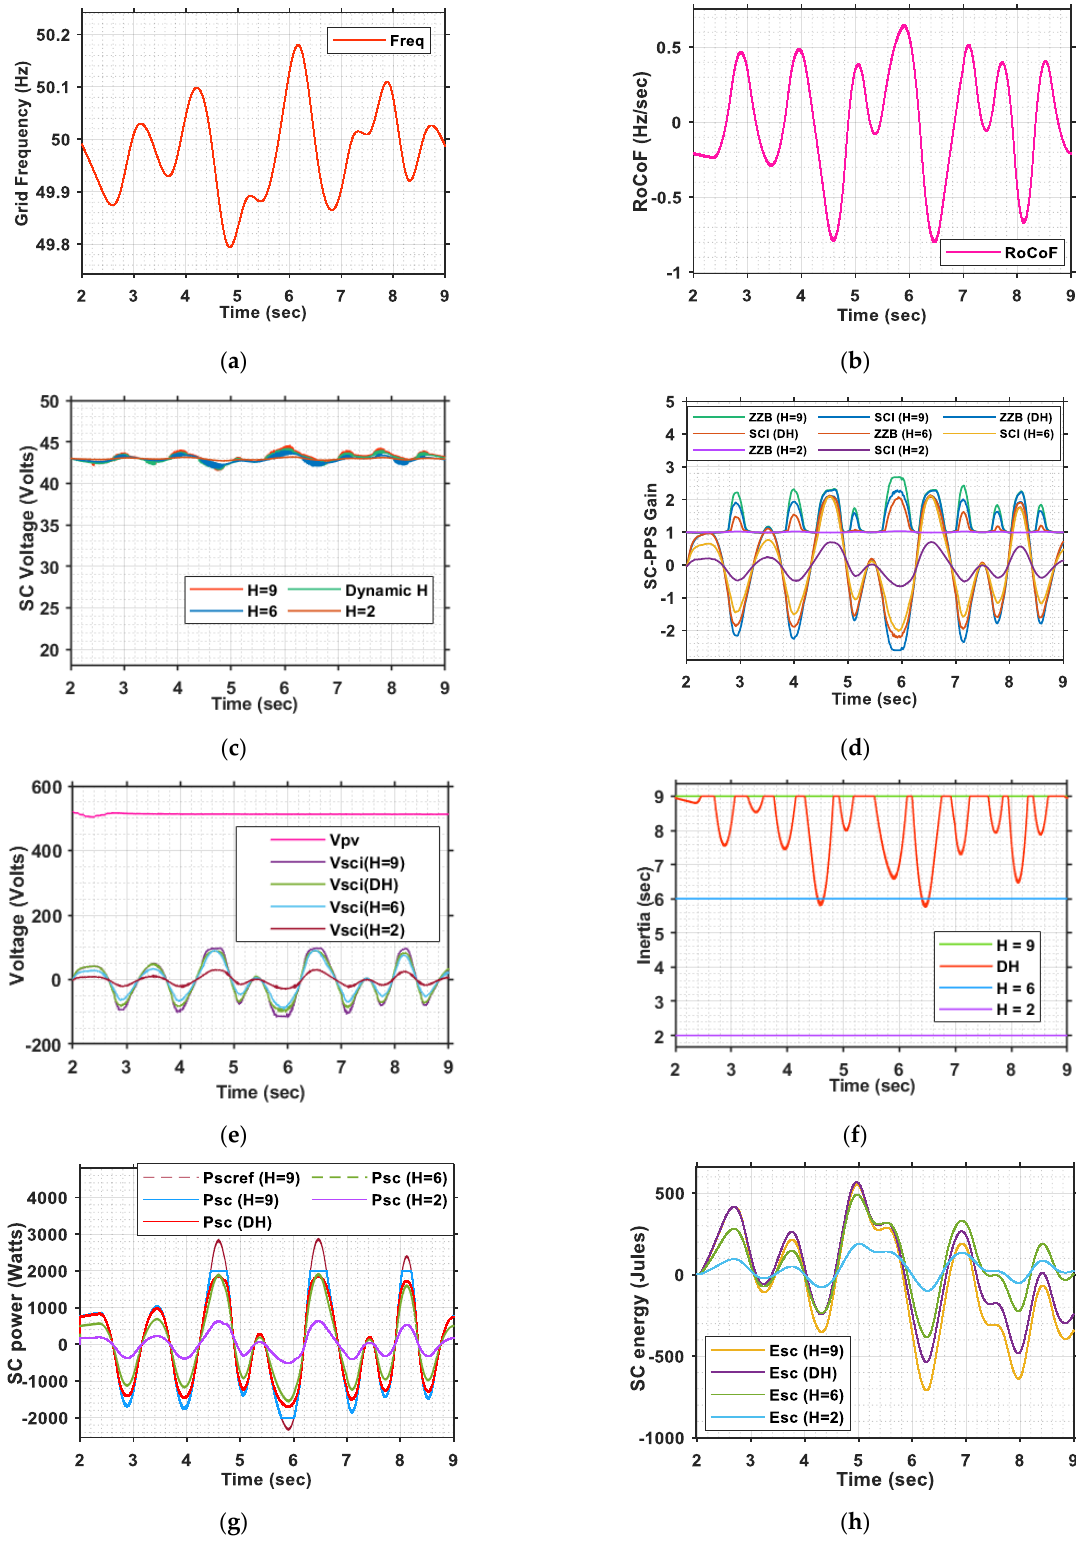
Figure 20. MATLAB simulation results for SIR based on various case studies: ( a ) low-frequency variation in Grid Frequency; ( b ) RoCoF subjected to variation in frequency; ( c ) variation in SC voltage; ( d ) voltage gain of the SC-PPS; ( e ) PV and SCI voltages; ( f ) emulated Inertia; ( g ) output power of the SC; ( h ) output energy of the SC.